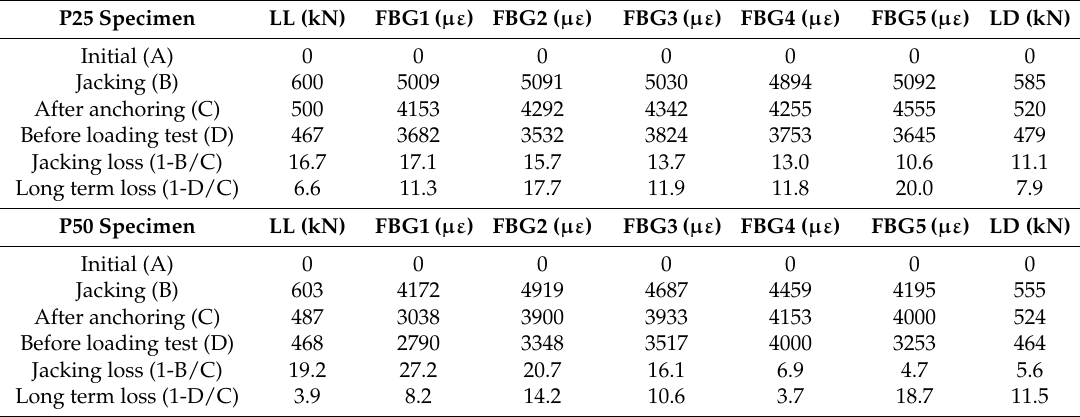
Table 1. Results from monitoring pre-stress and corresponding pre-stress loss.